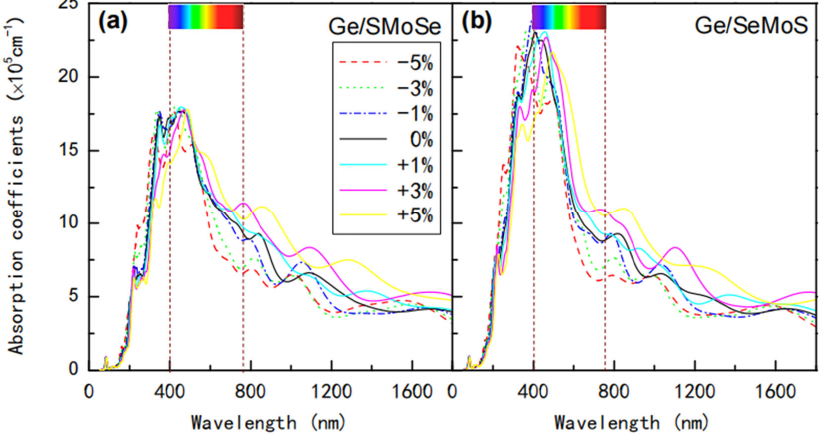
Figure 9. Optical absorption coefficients of ( a ) Ge/SMoSe and ( b ) Ge/SeMoS heterostructures under different strains.